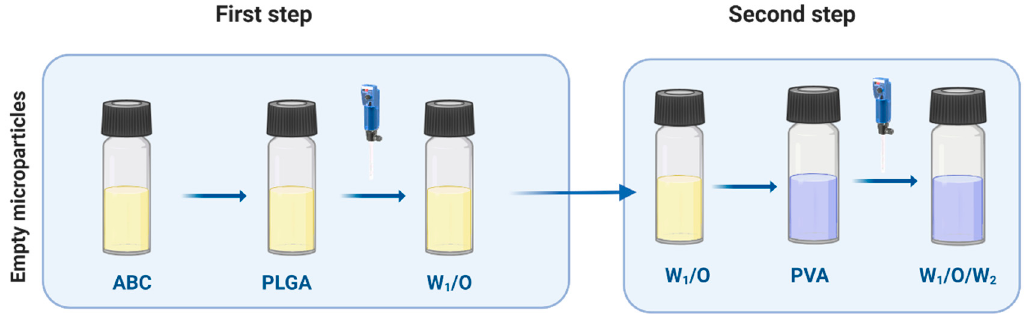
Figure 2. Double-emulsion solvent evaporation method (W 1 / O / W 2 ). Fabrication of empty microparticles Figure 2. Double ‐ emulsion solvent evaporation method (W 1 /O/W 2 ). Fabrication of empty microparticles (MPs).